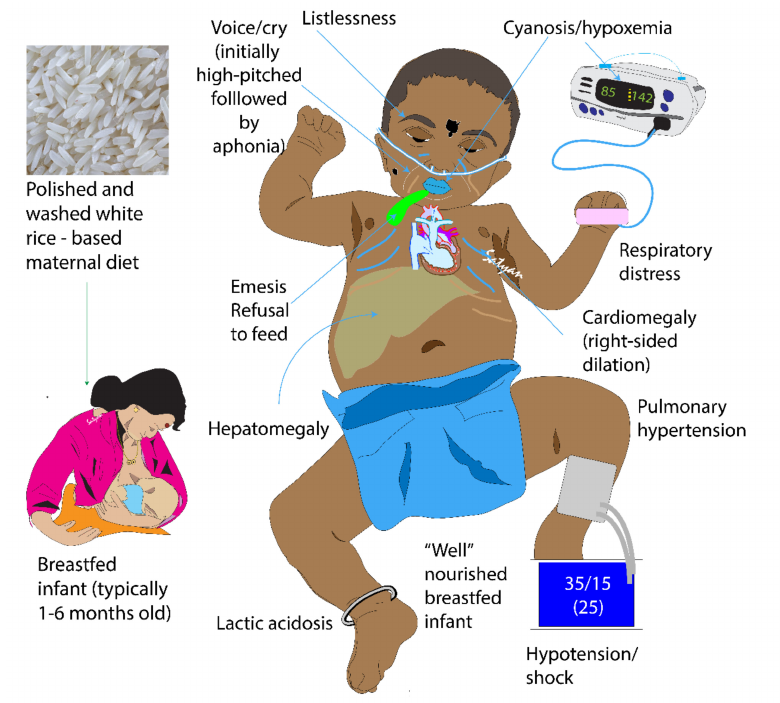
Figure 3. Clinical Features of thiamine-responsive acute pulmonary hypertension in early infancy (TRAPHEI) (copyright Satyan